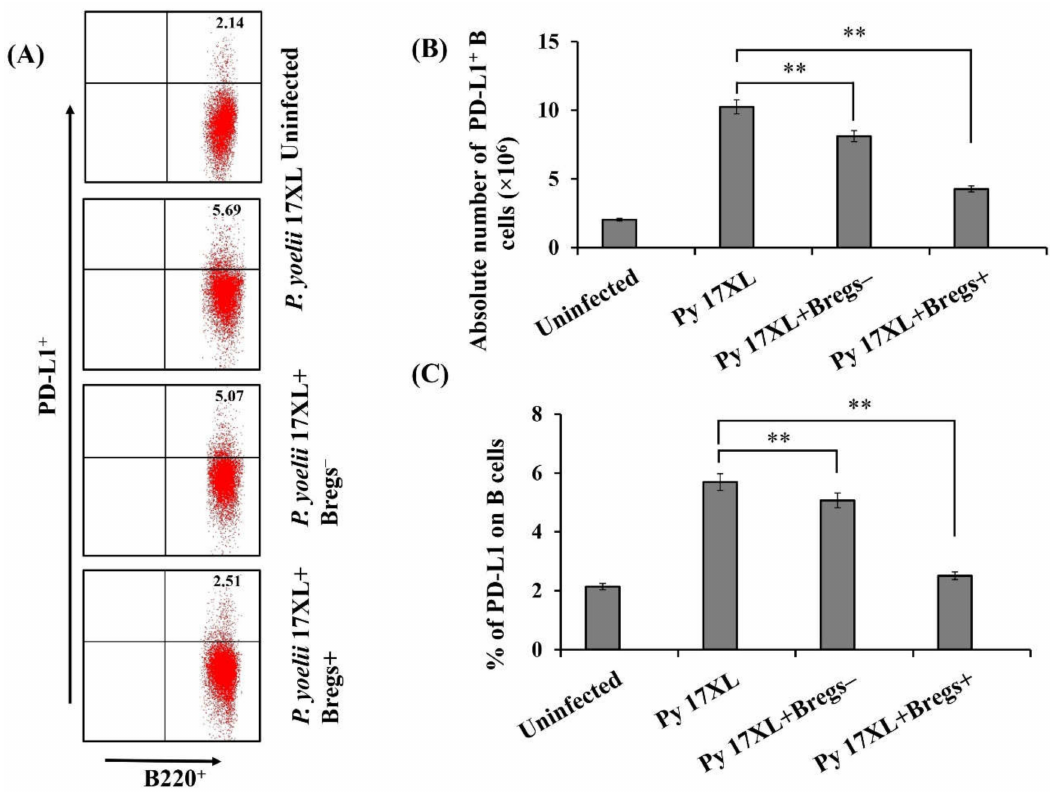
Figure 7. Effect of adoptive transfer of regulatory B cells on the expression of PD-L1: Splenocytes were harvested from Py 17XL infected mice infused with IL-10 + B cells or IL-10 − B cells, only infected and normal uninfected control. ( A ) Spleen cells were stained against PD-L1 andB220 using fluorescent tagged antibodies. Splenocytes were gated on whole lymphocytes to determine PD-L1 + B cells. ( B ) Absolute of PD-L1 + B cells after adoptive transfer of Bregs ( C ) Percentage of PD-L1 expressing B220 + B cells in spleen of Py 17XL infected mice infused with either Breg + or Breg − cells, only Py 17XL infected and uninfected mice.(** p <